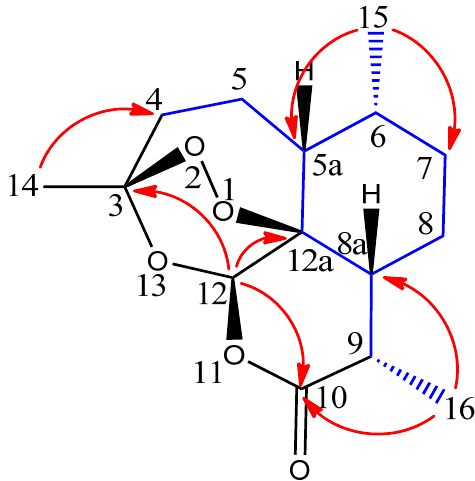
Figure 2. Key COSY (blue) and HMBC (red) correlations for ( − )-6-epi-artemisinin ( 2 ). Table 1. NMR Spectroscopic Data of 6-epi-( − )-artemisinin ( 2 ) 1 H (400 MHz, CDCl 3 ) and 13 C (100 MHz, CDCl 3.